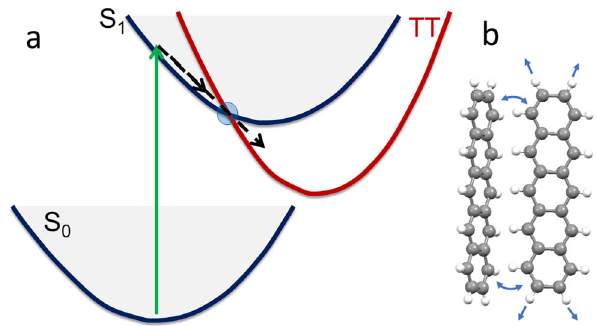
Fig. 2 The role of geometrical rearrangements in singlet fi ssion. a After photoexcitation (green) from S 0 , molecular motions (dashed) on the S 1 potential energy surface propel the geometry toward the curve crossing with TT. b Both intramolecular (straight arrows) or intermolecular (curved arrows) motions can facilitate ultrafast conversion to the